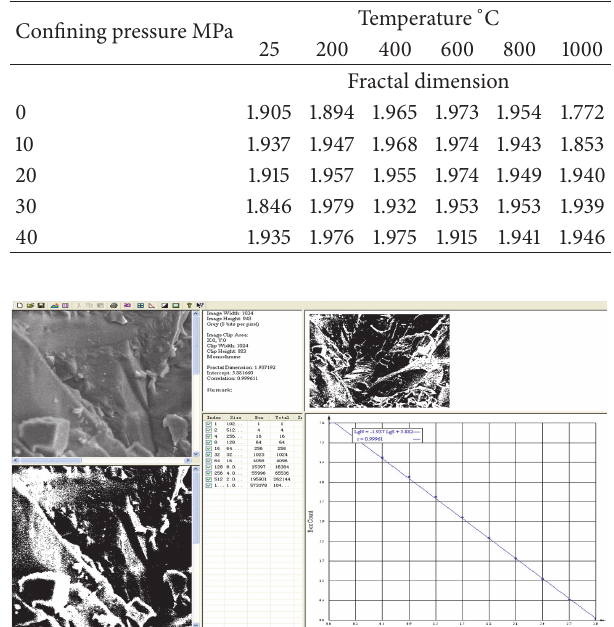
Table 1: Average value of fractal dimension of rock fracture under different temperature and confining pressure.